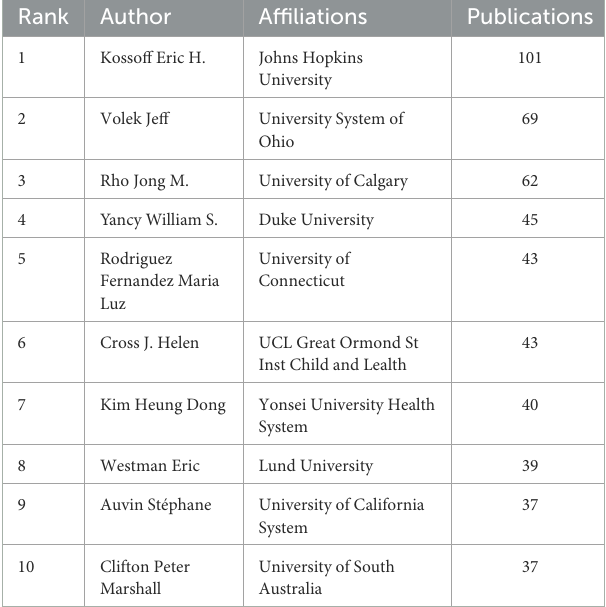
TABLE 4 The top 10 authors on LChD from 2002 to